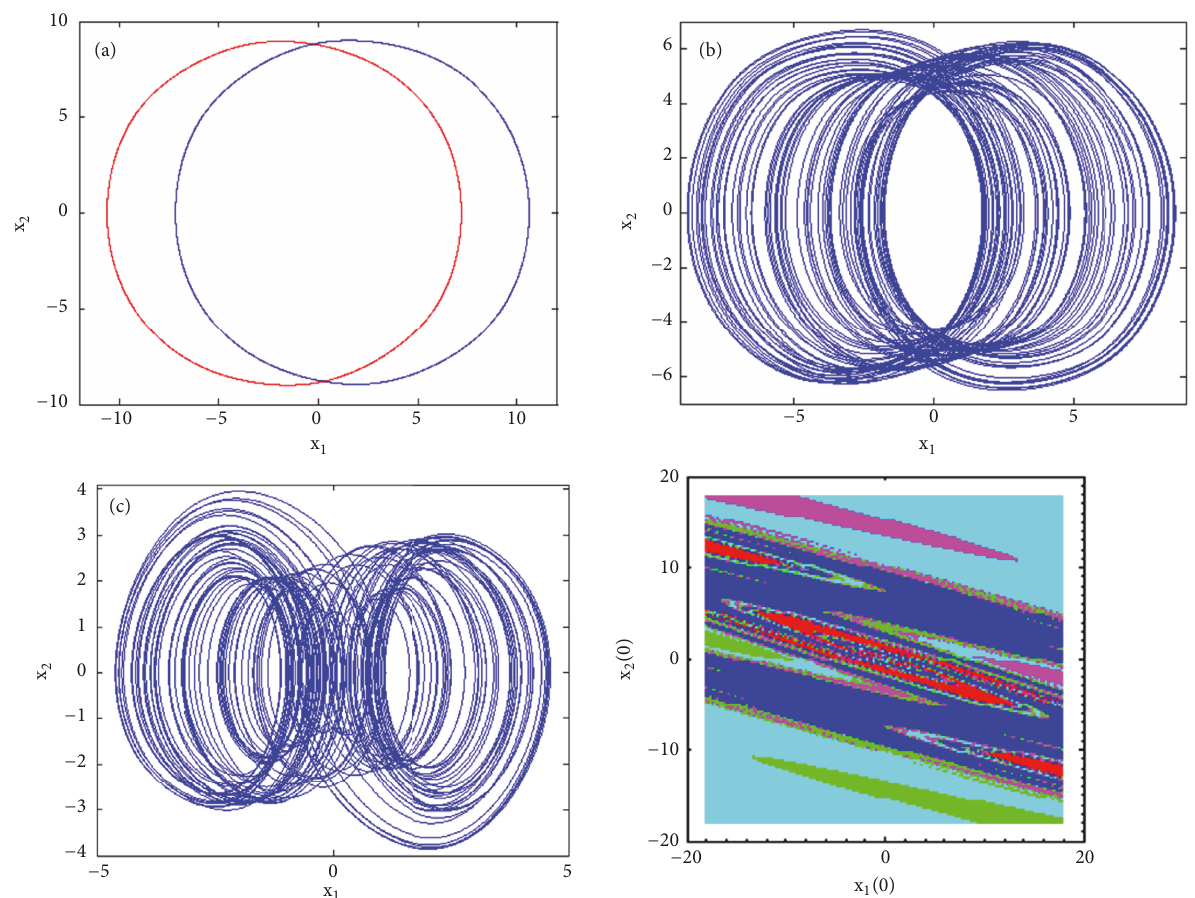
Figure 8: Coexistence of four different attractors (a pair of period-1 limit cycles and two different symmetric attractors) for a 2 = 2.458 with the rest of system’s parameters as follows: b = a 1 = 3, a 0 = 1.75, a 3 = 1, a 4 = 0.0054. Initial states are given in Table